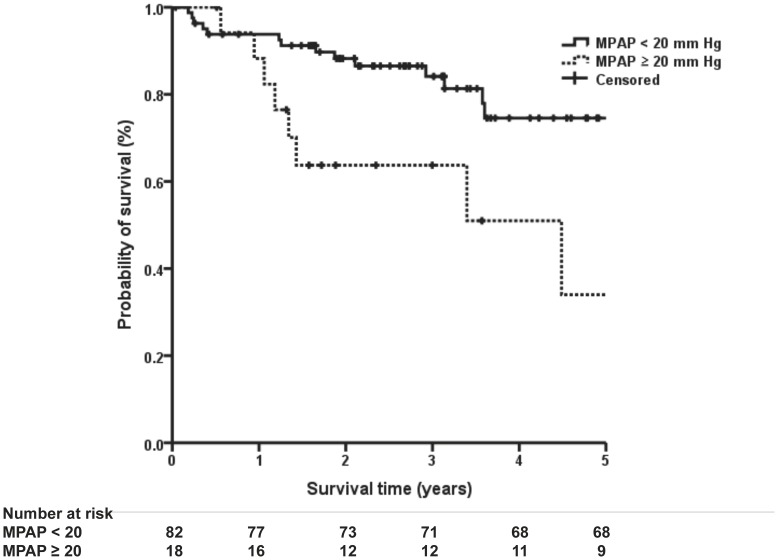
Kaplan-Meier curves for survival according to MPAP (p = 0.005).Survival curves were compared with log-rank statistics.